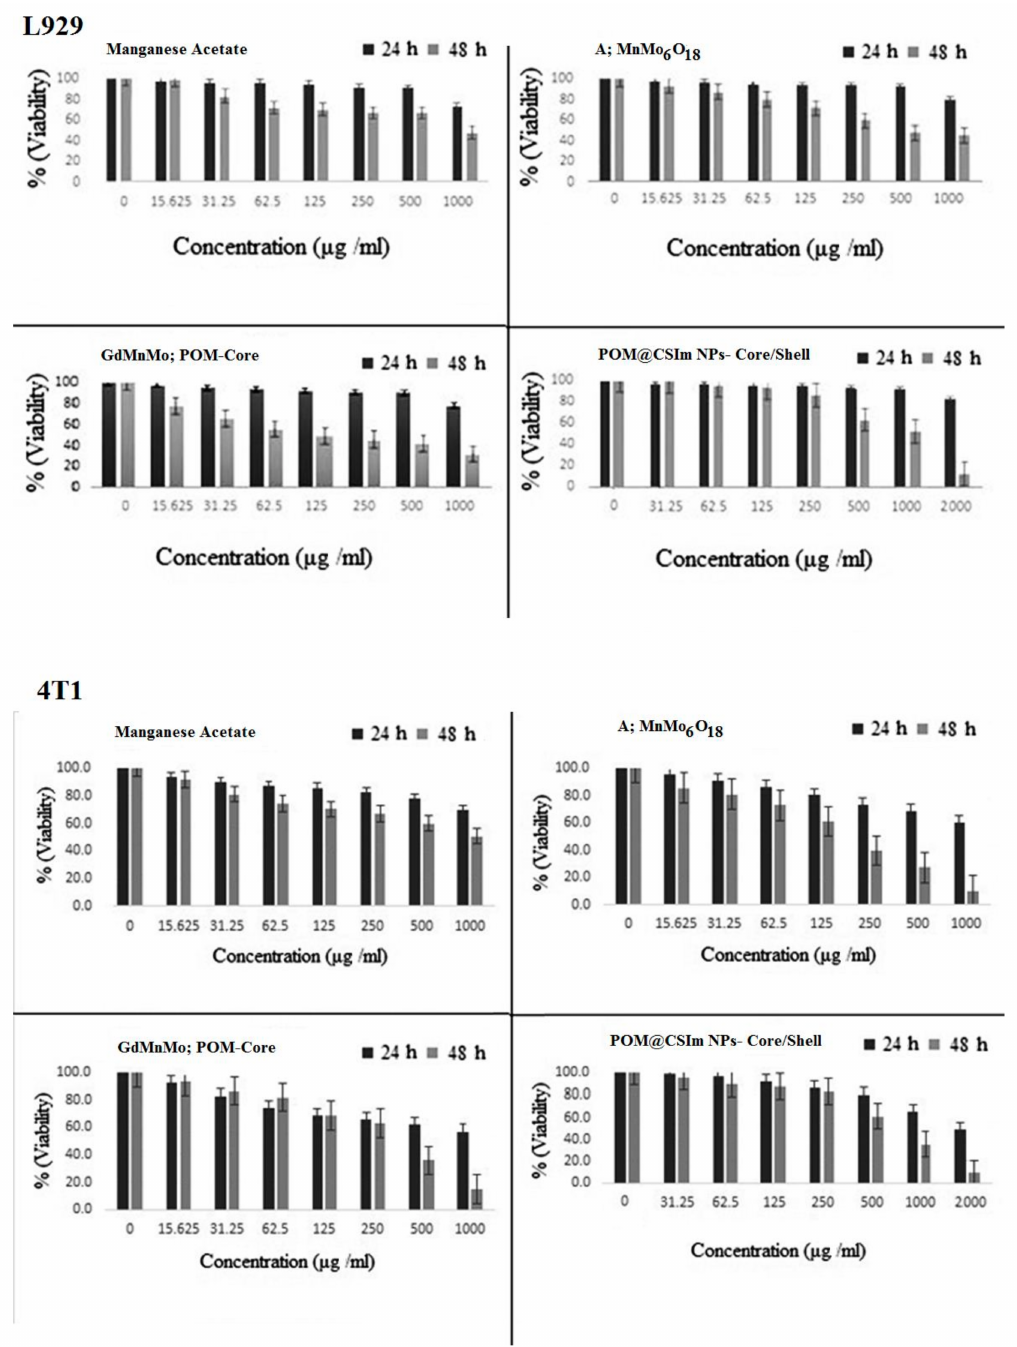
Figure 6. Cytotoxicity results of (GdMnMo) POM@CSIm on L929 and 4T1 for four compounds: manganese acetate 24 h and 48 h, A; MnMo 6 O 18 24 h and 48 h; POM-core 24 h and 48 h; and core/shell 24 h and 48